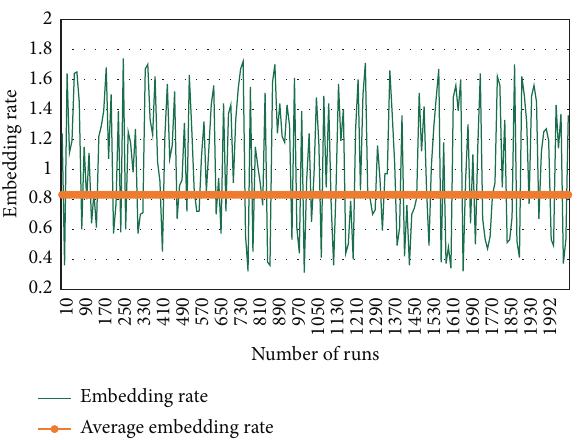
Figure 6: Schematic diagram of secret information embedding rate results with a length of 30 words.